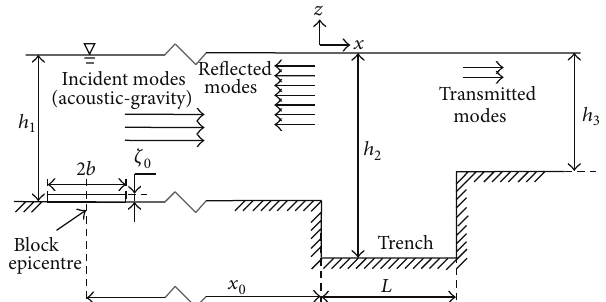
Figure1:Schematicrepresentationoftheflowdomain; ℎ 1 and ℎ 3 are the depths of the ocean at the two sides of the trench; ℎ 2 and 𝐿 are the depth and width of the trench, respectively; 2𝑏 and 𝜁 0 are the lateral and vertical extents of the bottom motion; 𝑥 0 is the distance between the earthquake epicentre and the incidence side of the